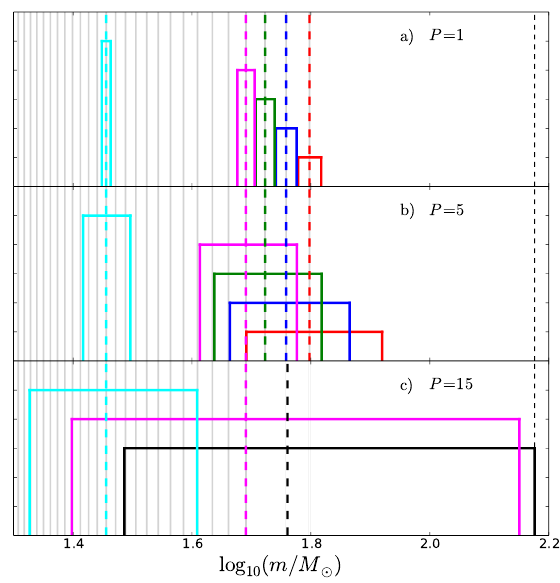
Fig.3. Masses of the OS stars (gray vertical lines), with those for the 1 st , 2 nd , 3 rd , 4 th , and 15 th most massive stars indicated by colored vertical dashed lines, respectively from right to left. The associated resampling bins are shown for several values of the expansion factors: P = 1 (a), 5 (b), and 15 (c). In the case of a large enough expansion factor (c), the resampling bins of the three most massive stars (red, blue, and green) are grouped in a common bin (black solid line), in which they will be resampled. The mean mass of the bin, taken as the mean of the OS masses of the three stars, is shown by a thick black dashed line. The thin dashed line at the right marks the high-mass limit, 150 M (cid:12)